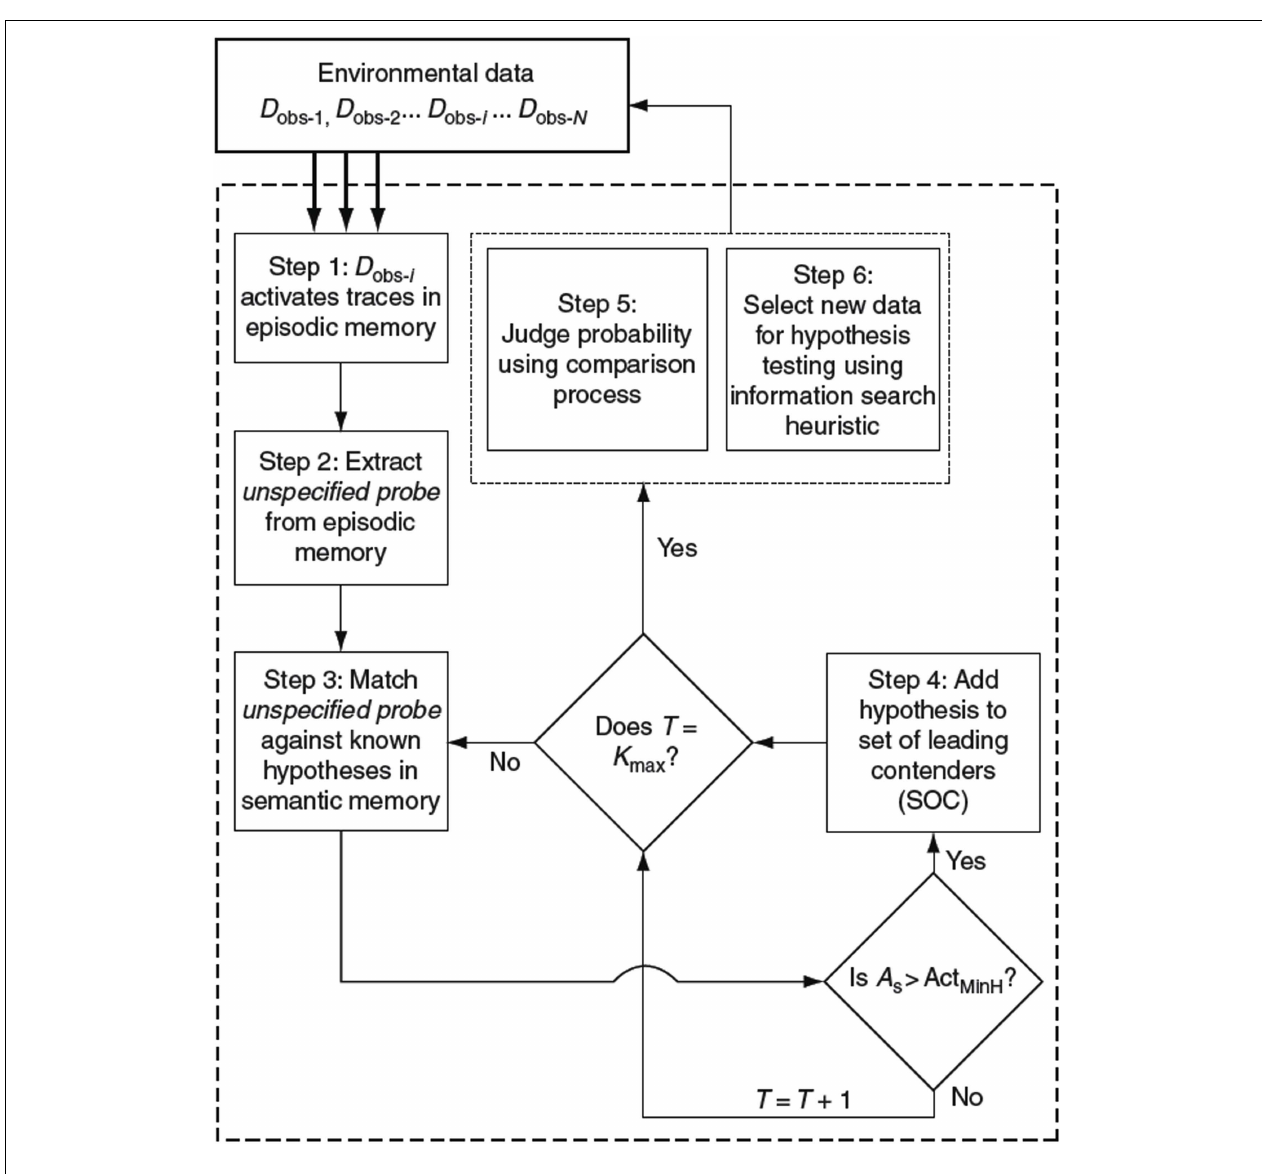
of hypothesis in SOC; T , total number of retrieval failures; and K max , number of retrieval failures allowed before terminating hypothesis